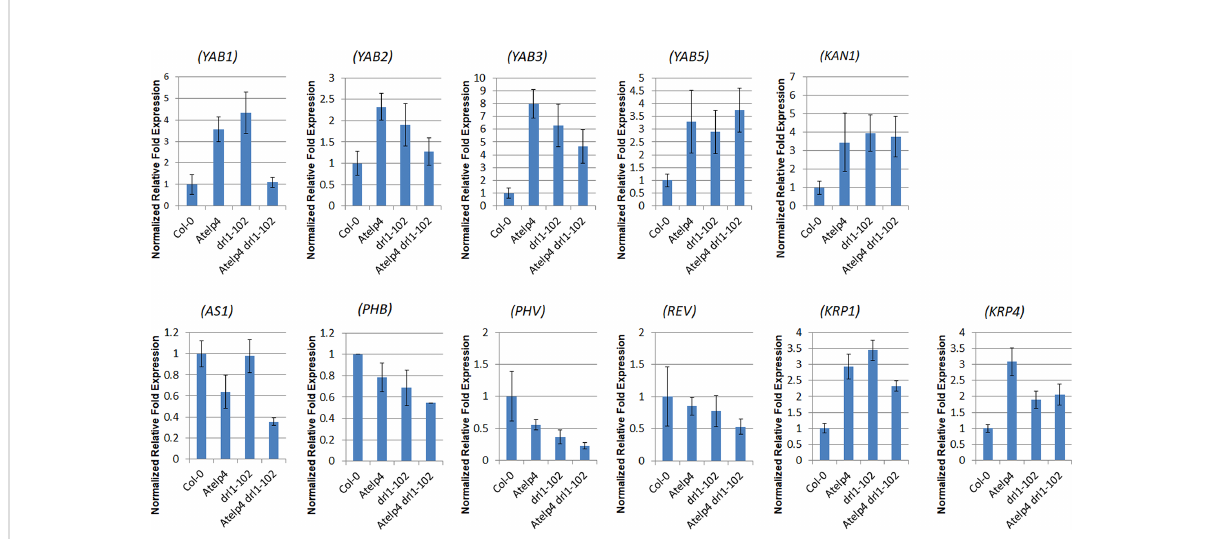
FIGURE 9 Expression level of leaf polarity- and cell proliferation-relative genes in Atelp4 and drl1-102 single and double mutants. Identical amounts of total RNA isolated from 21-day-old rosette leaves of wild type (Col-0), Atelp4 , drl1-102 , and Atelp4 drl1-102 were subjected to qRT-PCR experiments to analyze the expression level of leaf polarity- and cell proliferation-relative genes. The expression level of analyzed genes was normalized by that of TUB4 . Primer sequences of used genes are described in Supplementary Table